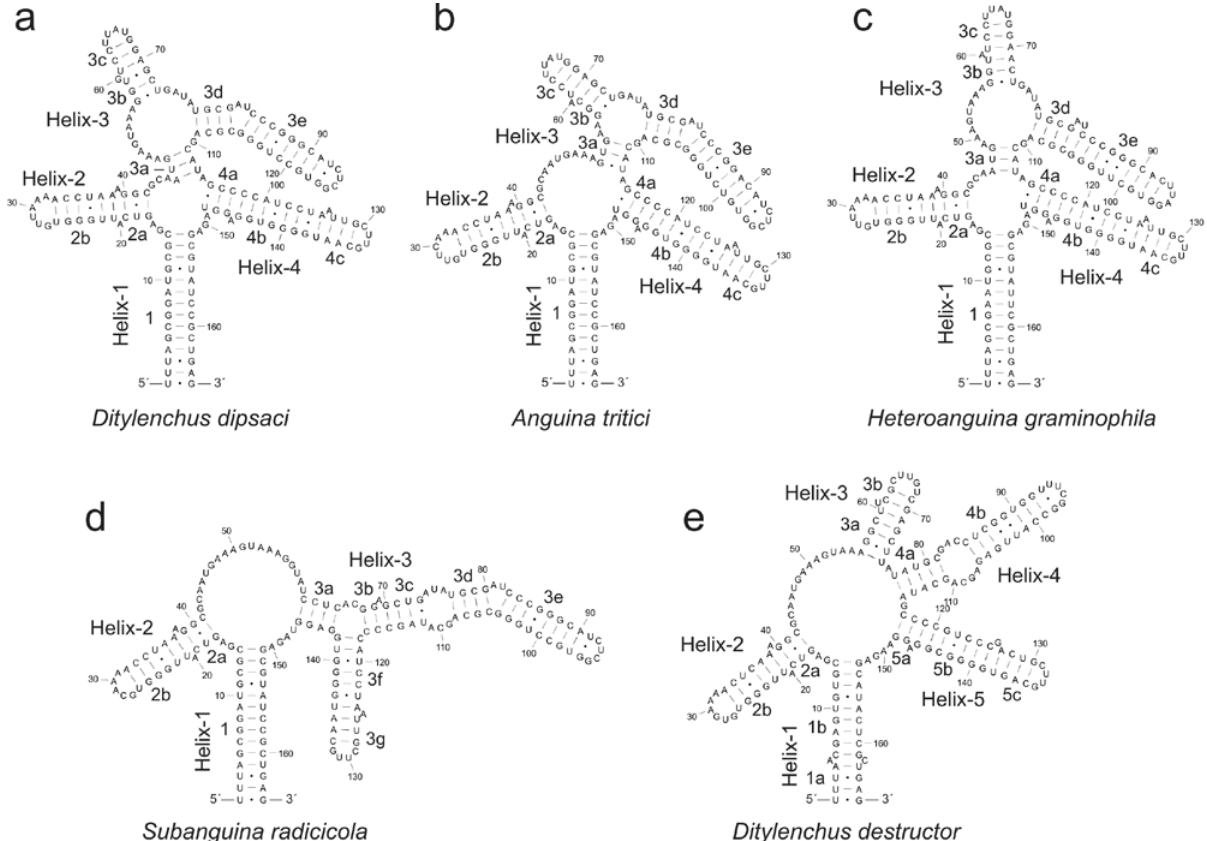
Figure 5. Secondary structure models of the D3-28S rRNA expansion segments for Ditylenchus dipsaci ( a ), D. destructor ( b ), Heteroanguina graminophila ( c ), Anguina tritici ( d ) and Subanguina radicicola ( e ). The models were computed by an energy- minimatization approach using the Mfold program and final adjustments of folded structures were performed with the RNAViz software. Bonds between C:G and U:A nucleotides are indicated by a straight line; bonds between U:G are indi - cated by a closed